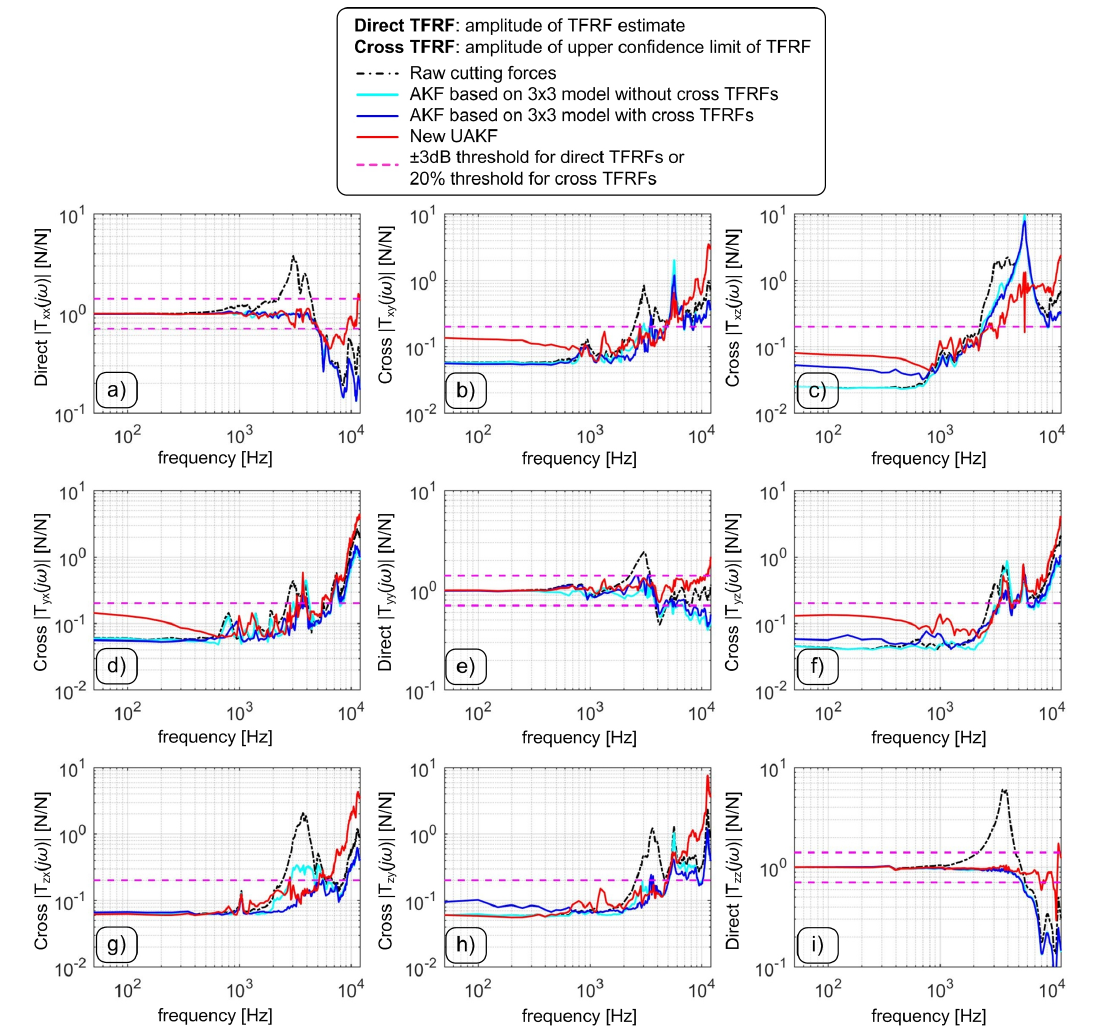
Figure 5. Comparison between the transmissibility frequency response functions (TFRF) compensated by the novel Kalman filter (red) and the uncompensated TFRFs (black). Confidence limits were also determined in order to include the uncertainty affecting the estimates. Subfigures ( a – i ) are arranged in accordance with the TFRF matrix structure of Equation